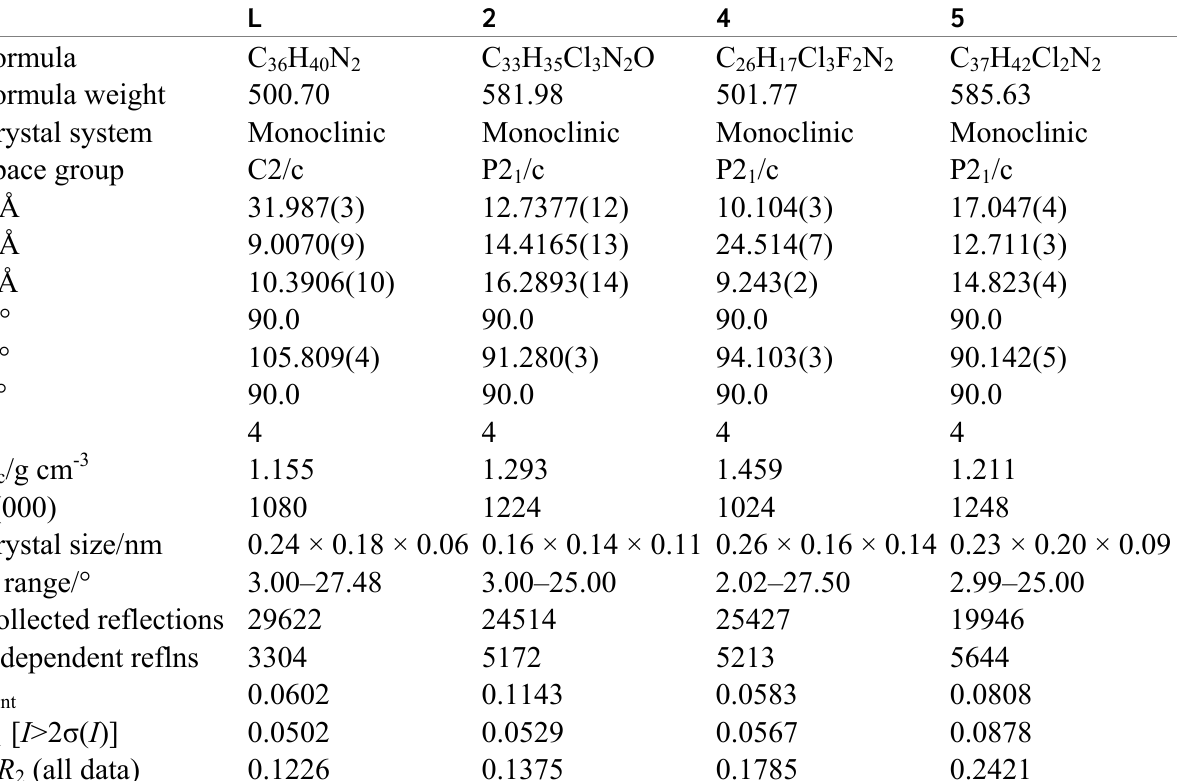
Table 1. Selected crystal data, data collection and refinement parameters for compounds L , 2 , 4 and 5